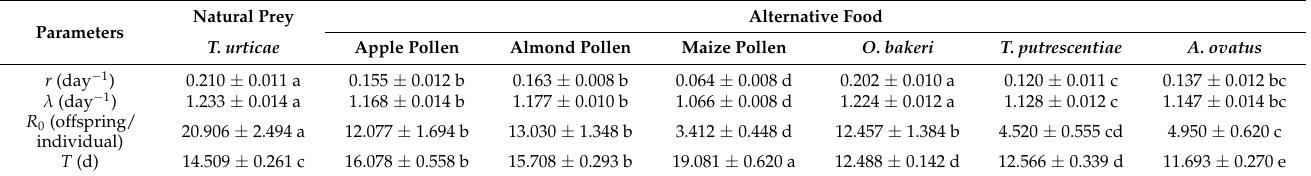
Table 2. Life table parameters of A. herbicolus fed on six alternative foods and its natural prey, T. urticae .